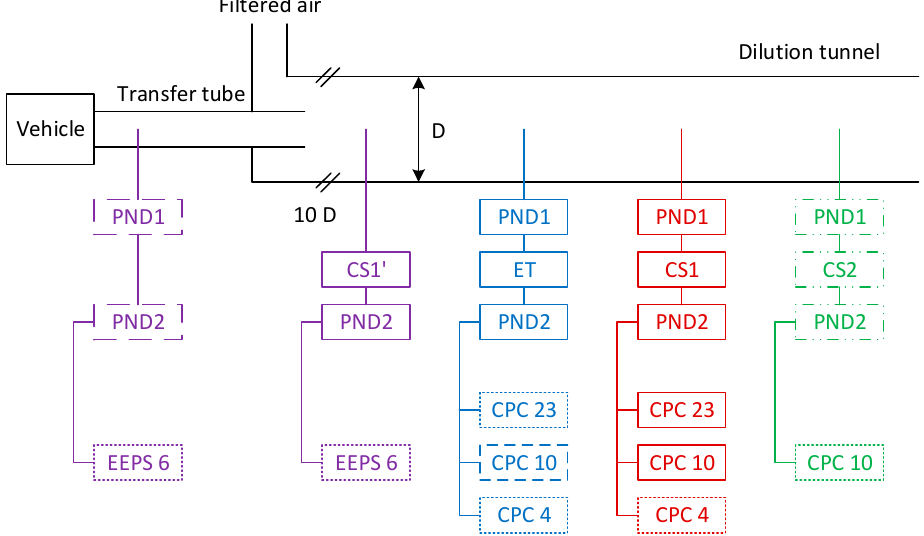
Figure 8. Experimental setup (not in scale). The four tunnel probes in the dilution tunnel were at the same cross-section. CS = catalytic stripper; CPC = condensation particle counter; EEPS = engine exhaust particle sizer; ET = evaporation tube; D = diameter; PND = particle number diluter. Continuous lines: AVL; dotted lines: TSI; double dotted lines: Horiba; dashed lines: Airmodus: large dashed lines: Testo.